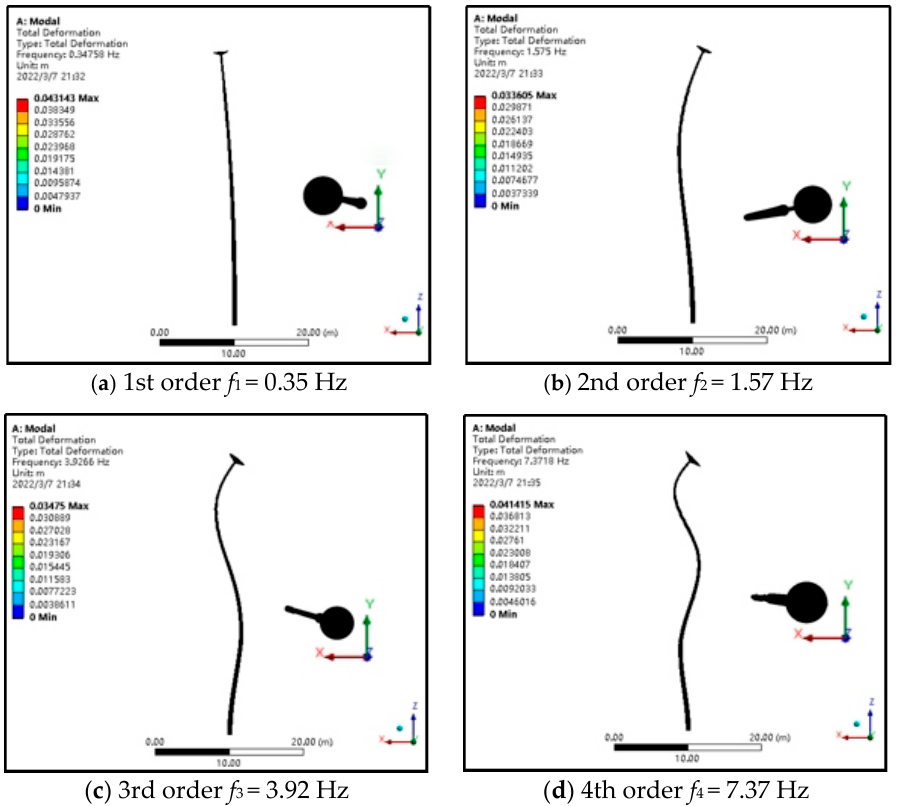
Figure 24. Modes of vibration of the P15D_H0.25D light pole of the first four orders obtained from FE simulation. Table 5. Comparison of the first four-mode frequencies of the light pole under different side plate height conditions.